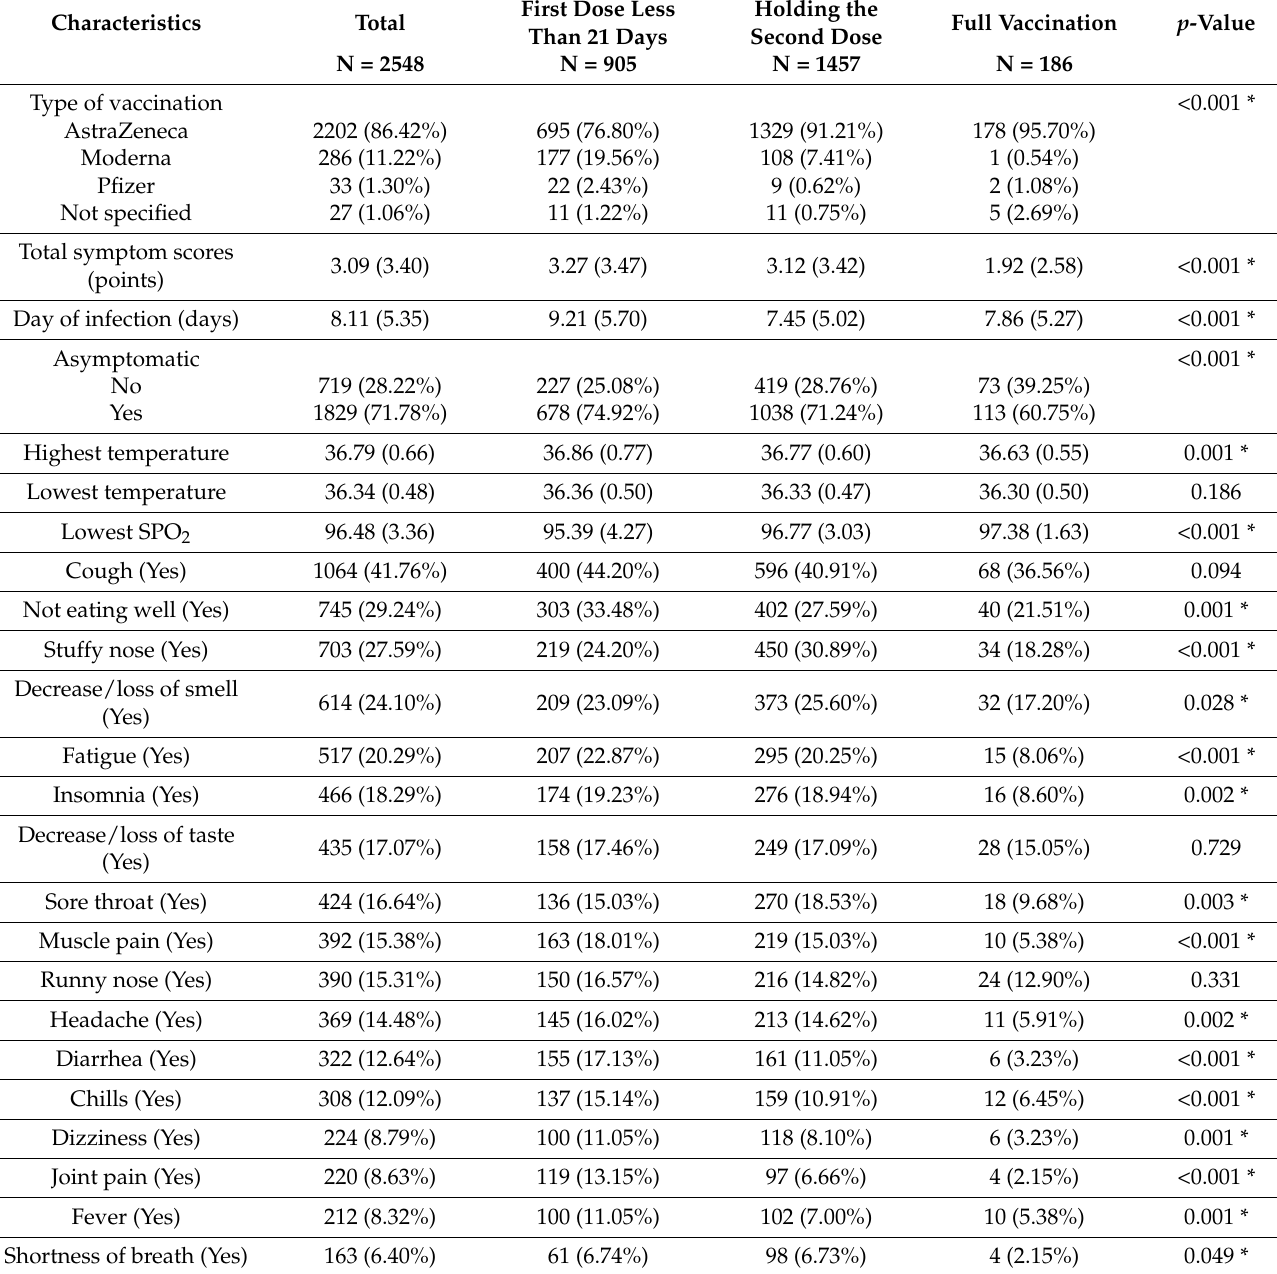
Table 1. Baseline patients’ characteristics according to their vaccination